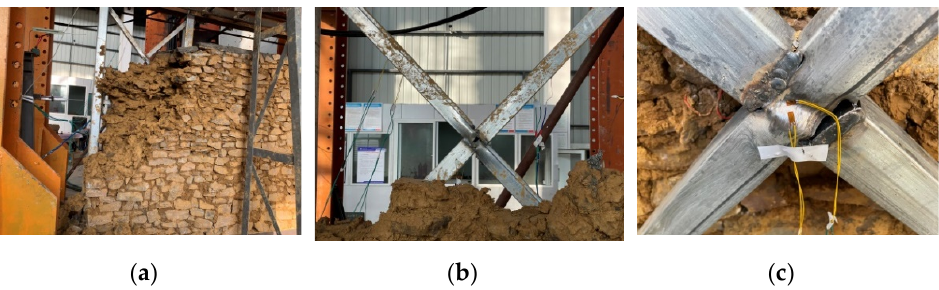
Figure 8. Test phenomena of FW-3 specimen: ( a ) Partial collapse of the left part wall; ( b ) Fracture failure at the intersection of upper bracings; ( c ) Welding failure at the intersection of the lower brace.